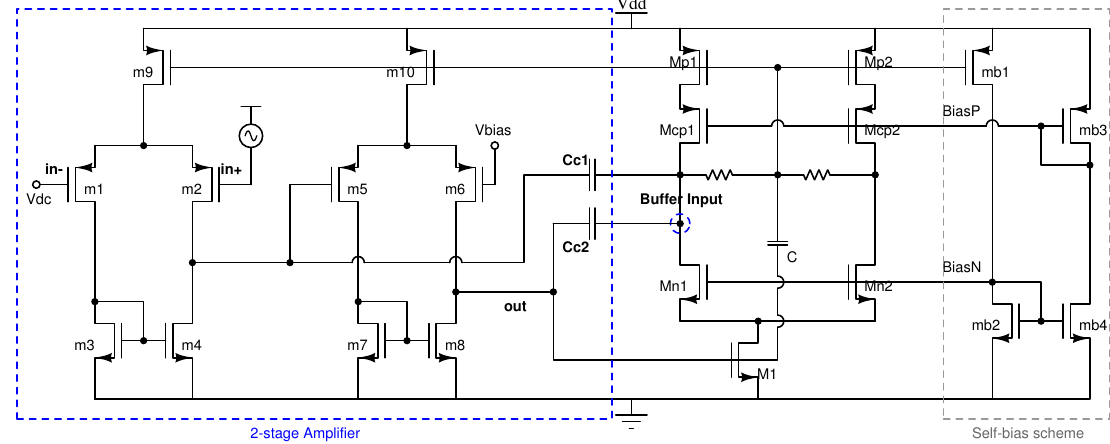
Figure 4. Open-loop configuration with a two-stage